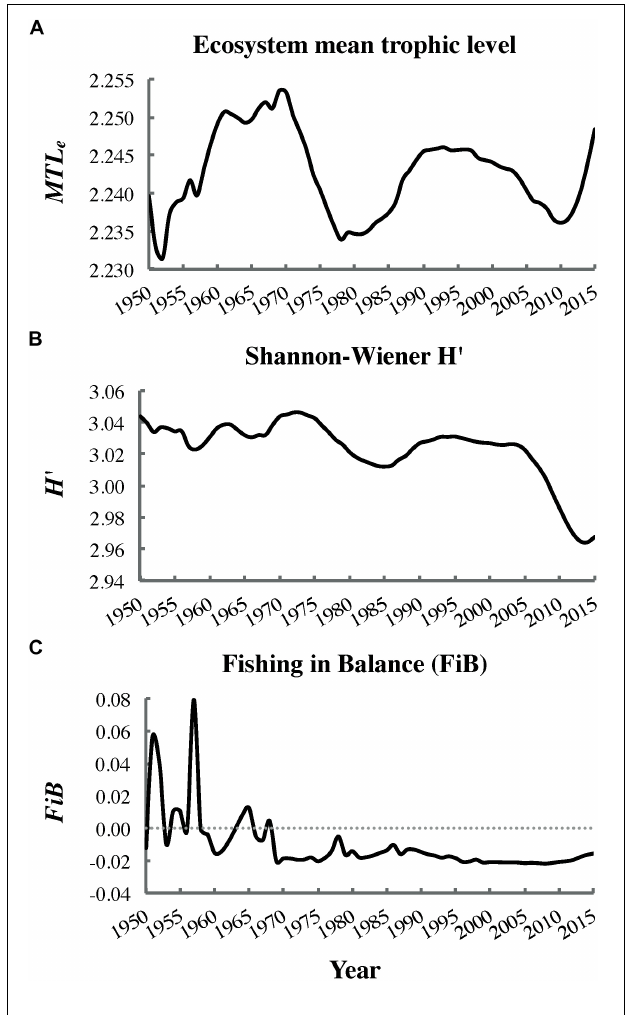
FIGURE 8 | Trends in the (A) ecosystem mean trophic level MTL e (non-significant), (B) Shannon–Wiener biodiversity H (cid:48) (significant), and (C) fishing in balance index FiB (significant) from dynamic ecosystem simulation outputs (most parsimonious fit).